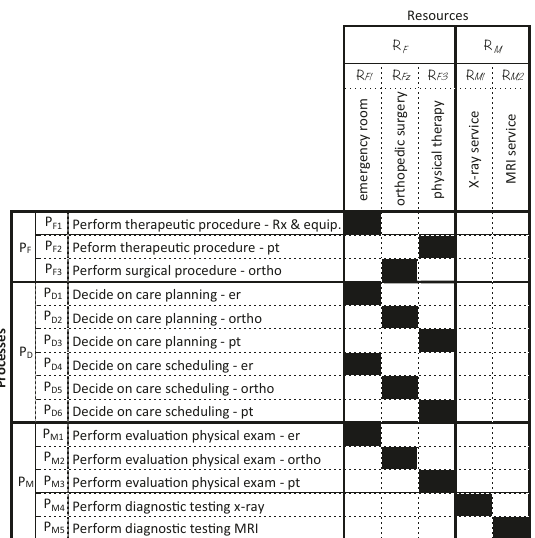
Figure 6: Higher level (transformation, decision, and measurement) knowledge base 𝐽 𝐹𝐷𝑀 with allocated aggregated processes to aggregated resources (dark filled), for the acute orthopedic example.